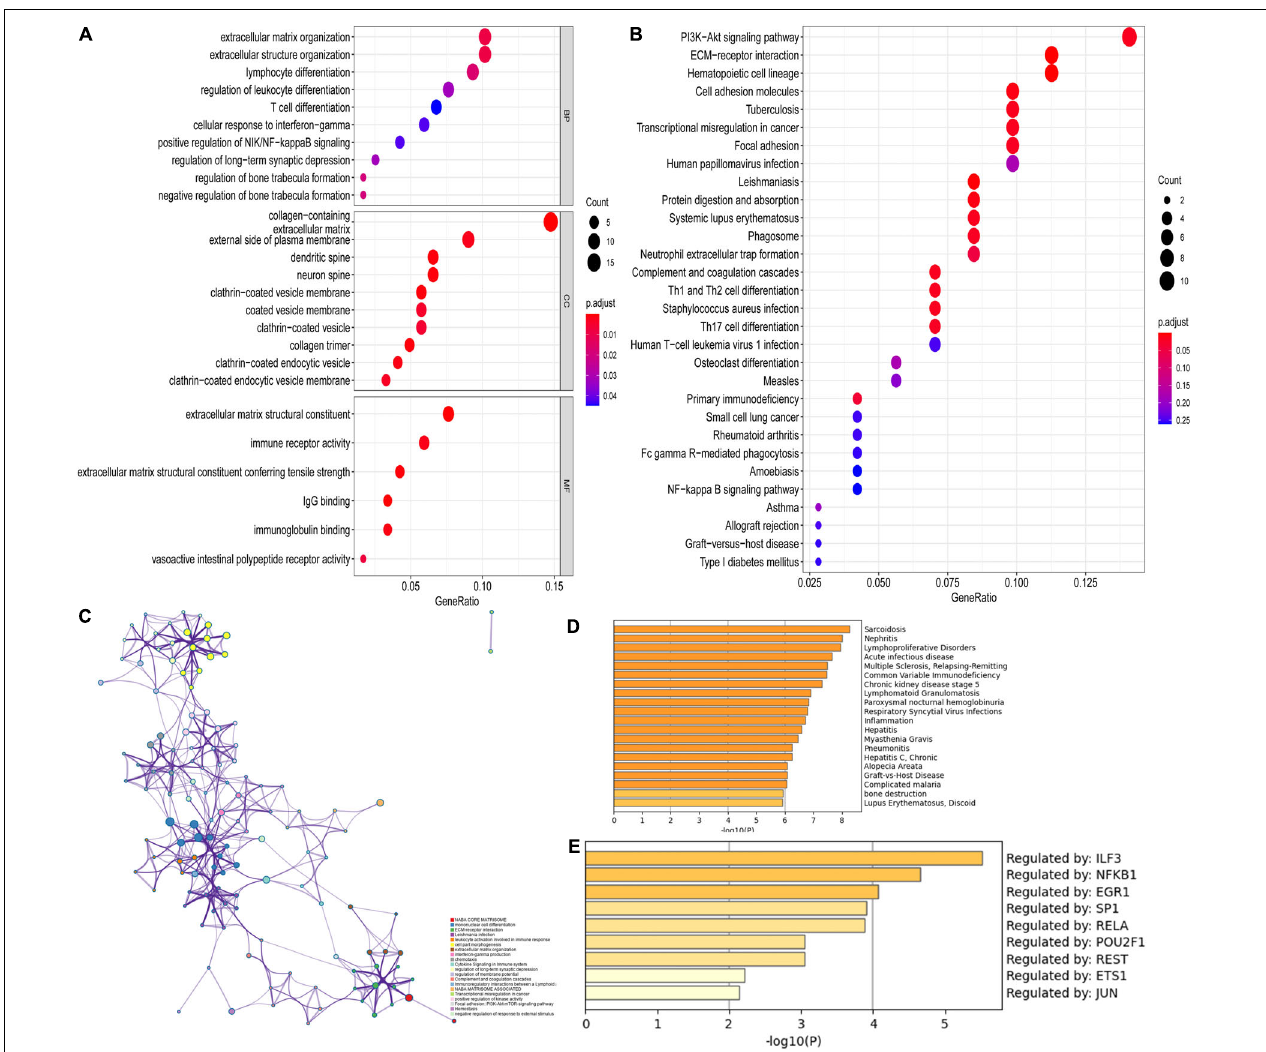
FIGURE 5 | Functional enrichment analysis of DEGs. (A) GO analysis for DEGs; (B) KEGG pathway enrichment analysis for DEGs; (C) The network for enriched terms by Metascape; (D) The results of DisGeNET database; (E) The results of transcriptional regulatory relationships unraveled by sentence-based text-mining (TRRUST)